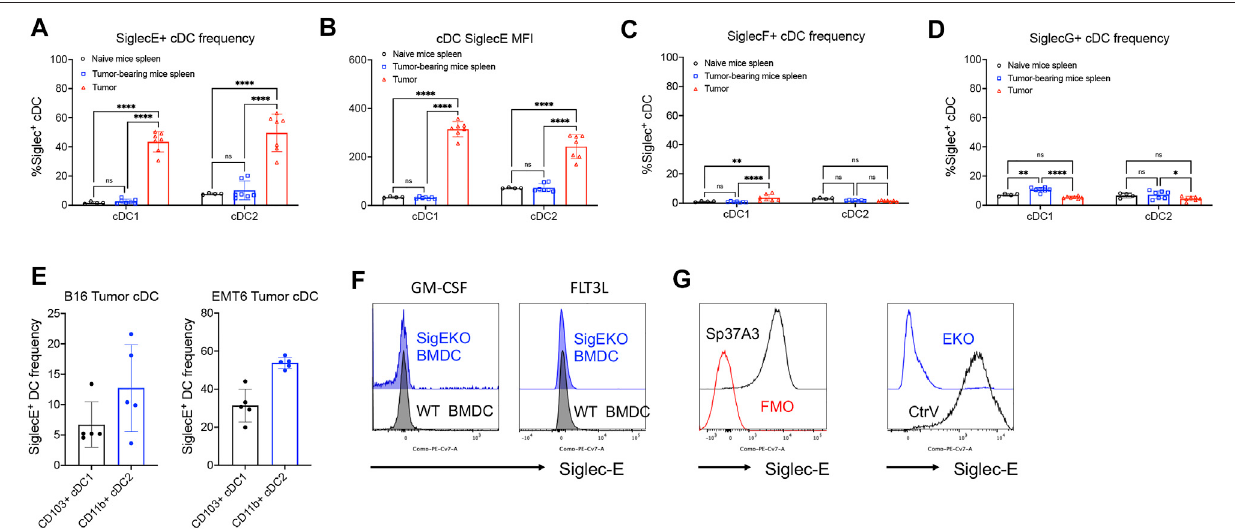
FIGURE 2 | Inhibitory Siglec-E expression is signi fi cant on mouse tumor-associated DCs. (A – D) The expression patterns of several murine inhibitory Siglecs on cDCsisolatedfromnaiveC57BL/6micespleens,MC38tumor-bearingmousespleens,andprimarysubcutaneoustumorswereanalyzedby fl owcytometry. (A) SiglecE + cDCfrequency, (B) SiglecE MFI, (C) SiglecF+ cDCfrequency, and (D) SiglecG + cDCfrequency. (E) Siglec-Eexpression ontumor cDCsubsets from B16 melanoma and EMT6 breast cancer mouse models. (F) Siglec-E expression of BMDCs from wildtype (WT, black line) and systemic Siglec-E knockout (EKO, blue line) mice after 7-day in vitro culture supplemented with GM-CSF or FLT3L. (G) The expression of Siglec-E on Sp37A3 cell line (black line) versus FMO control (red line). Siglec-E expressionofSiglec-Eknockout(EKO)Sp37A3cellsandemptycontrolvector(CtrV)-transducedSp37A3cells.Dataarepresentedasmean±SD,andtwo-wayANOVA was used for two-way comparisons (* p < 0.0332, ** p < 0.0021, *** p < 0.0002, and **** p < 0.0001).